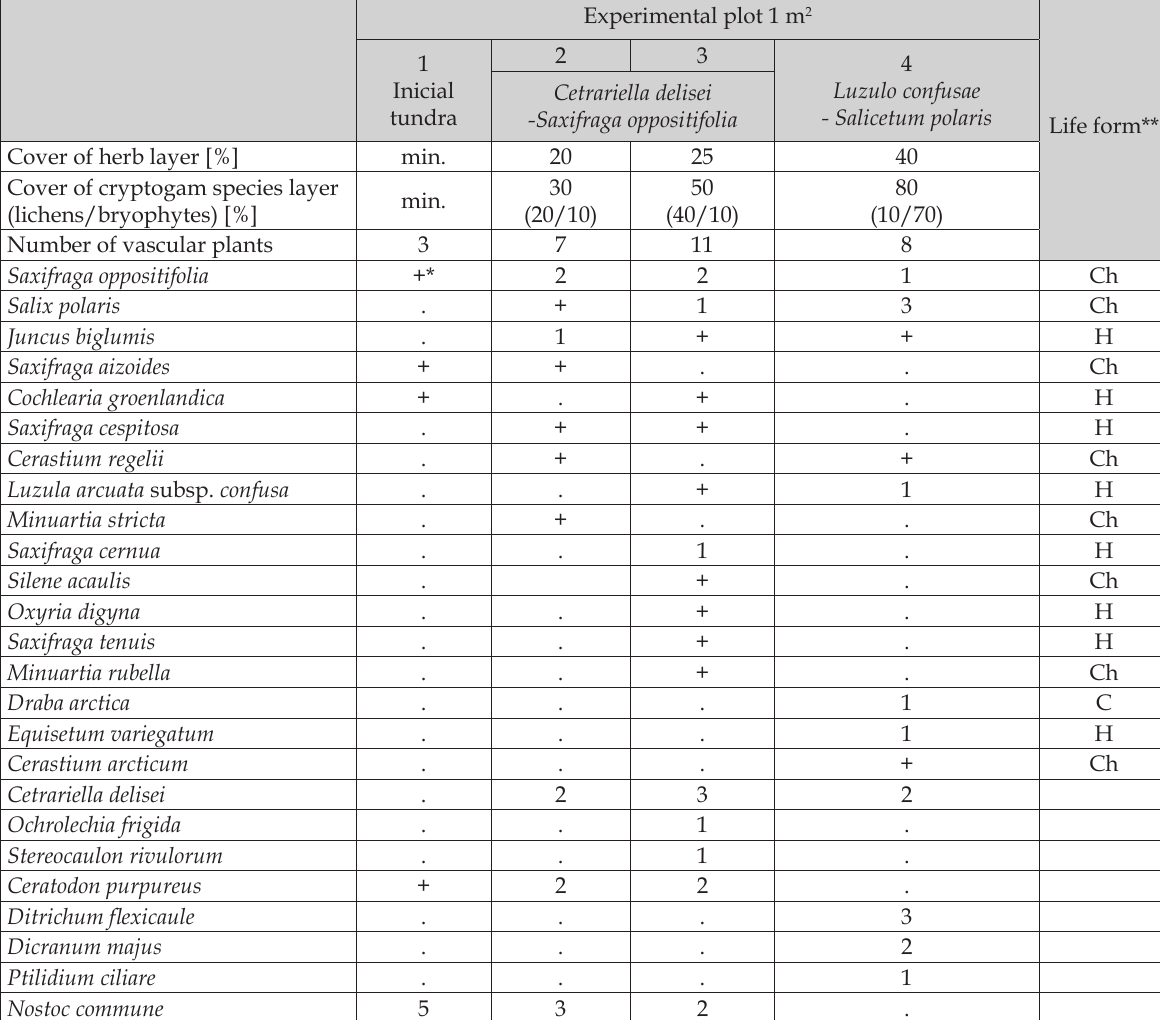
Table 1. Floristic structure of tundra phytocoenoses at the experimental plots 1–4 in the area of Kaffiøyra plain (Oscar II land, Spitsbergen) Experimental plot 1 m 2